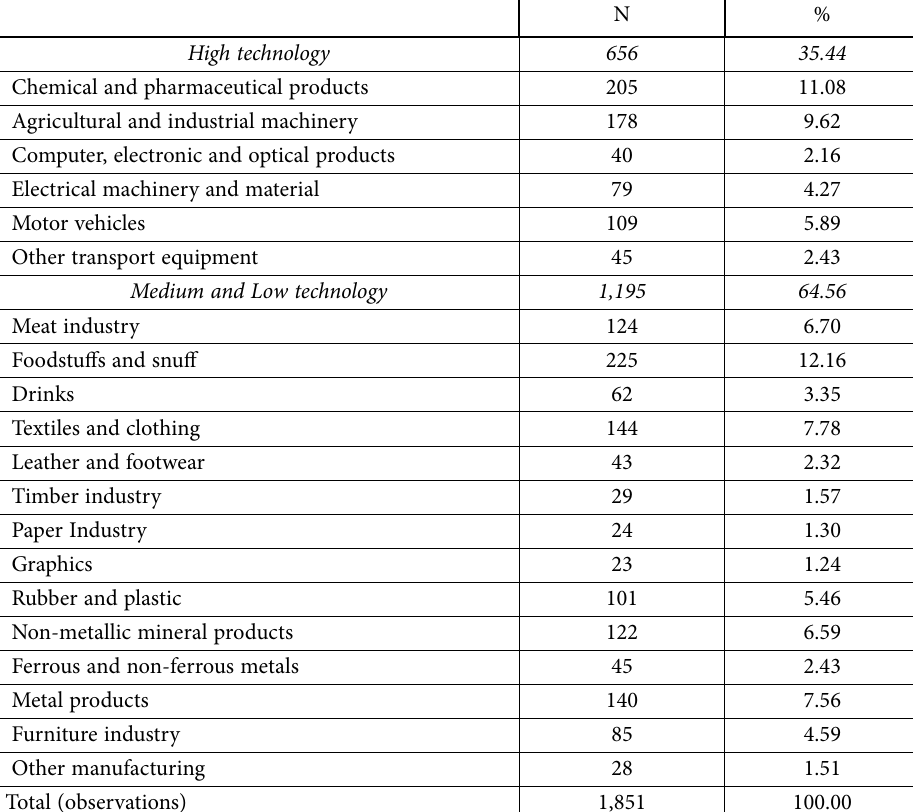
Table 1. Distribution of the sampled firms by sub-industry and technological intensity a